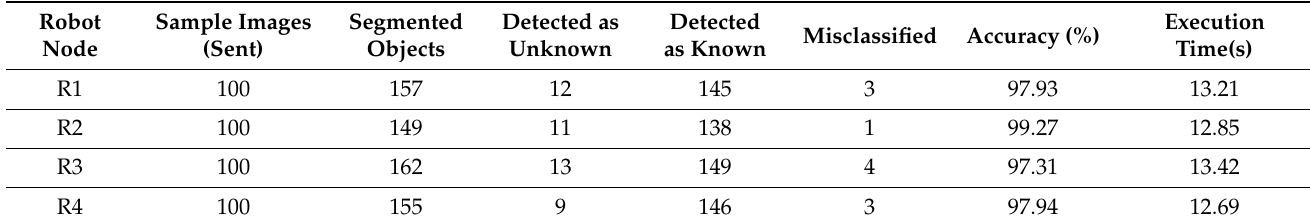
Table 5. Results for multiple robot nodes simultaneously sending data to the cloud-based station and receiving analysis information.